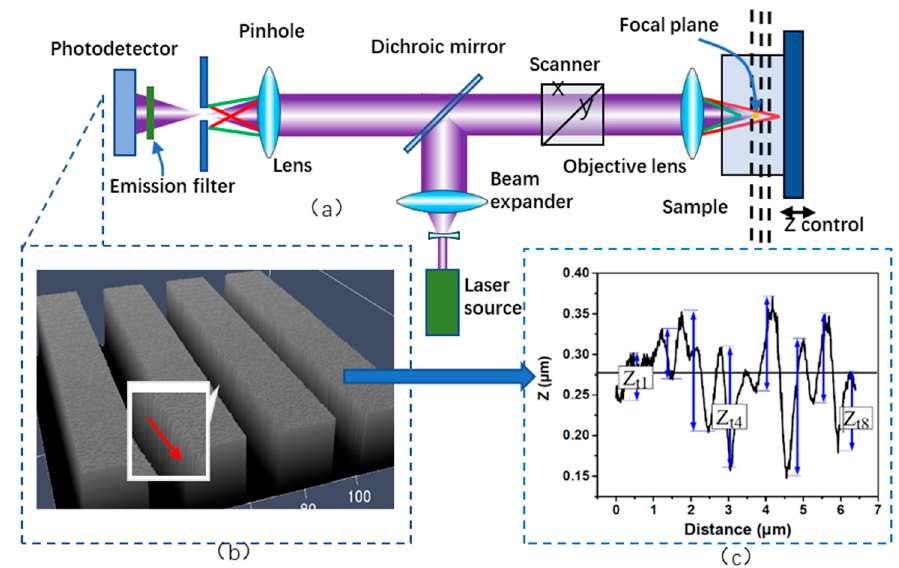
Figure 2. CLSM (confocal laser scanning microscopy) measurement and the definition for surface roughness: ( a ) The schematic optical imaging system, ( b ) the retrieved image of CLSM-measured result of an object, and ( c ) the definition for the fabricated surface roughness.